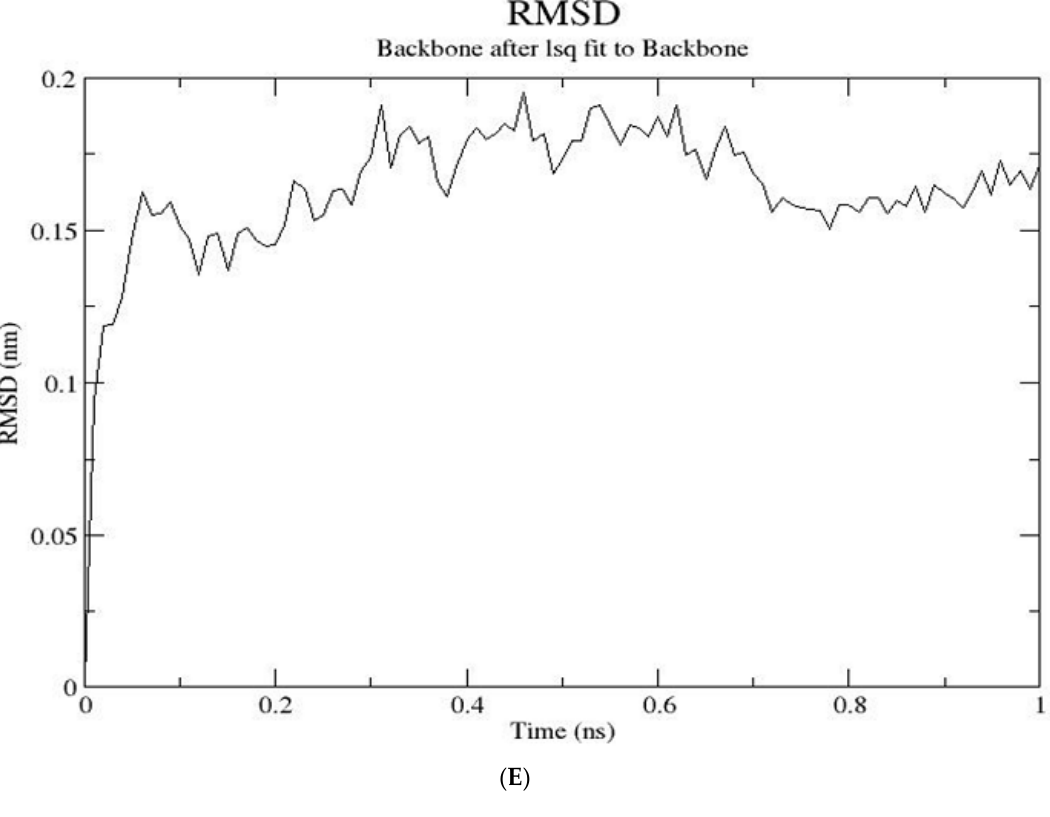
Figure 4. Graphs generated from molecular dynamics simulation. ( A ) Potential energy against time graph of the energy minimized protein produced from GROMACS. The overall potential energy of the model achieved after simulation was −1.9786255e+06 kcal/mol. ( B ) Temperature against time graph showing that the protein temperature was simulated within 300 K. ( C ) A graph of pressure against the time of the simulated protein model. The pressure laid within 1 bar over the period of 100 ps. ( D ) Density against the time graph of the protein after simulation led to an average density of 1018.14 kg/m 3 . ( E ) RMSD graph with deviation stabilizing around 1.6 Å at the end of 1 ns production run.